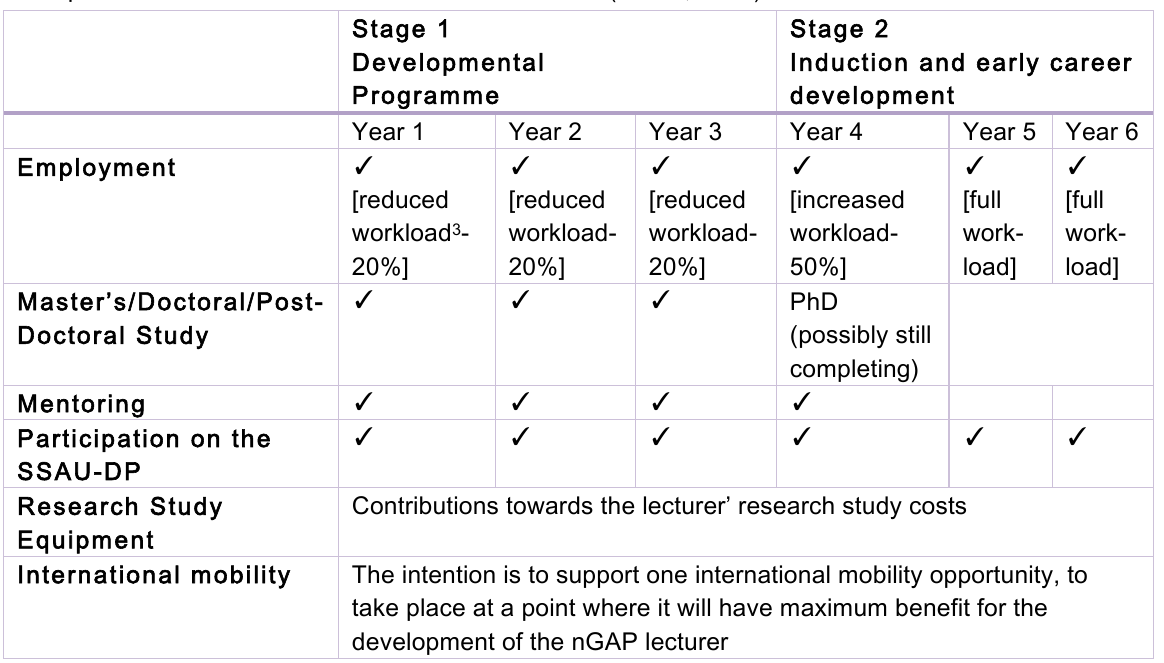
Table 1: The New Generation of Academics Programme (nGAP) * Adapted from nGAP terms and conditions document (DHET,